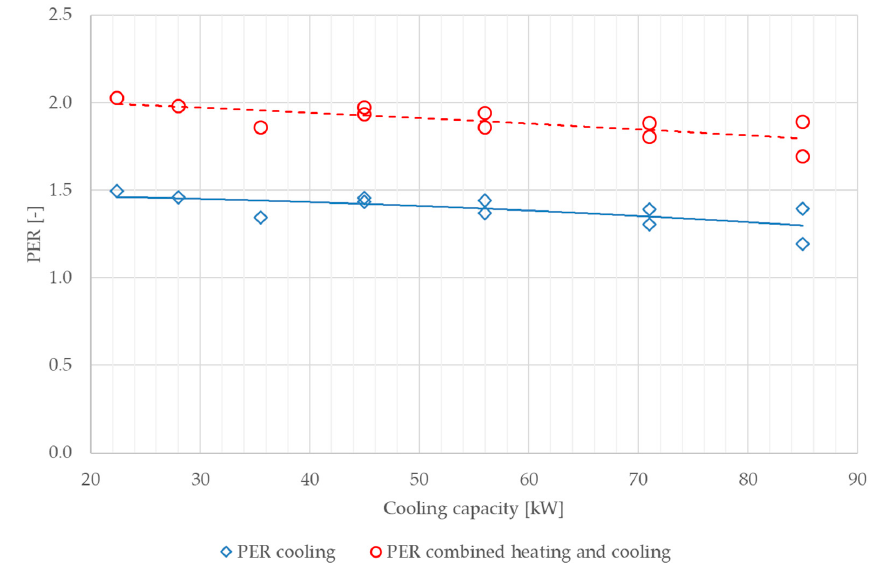
Figure 20. PER in GEHP in cooling mode without and with DHW kit.